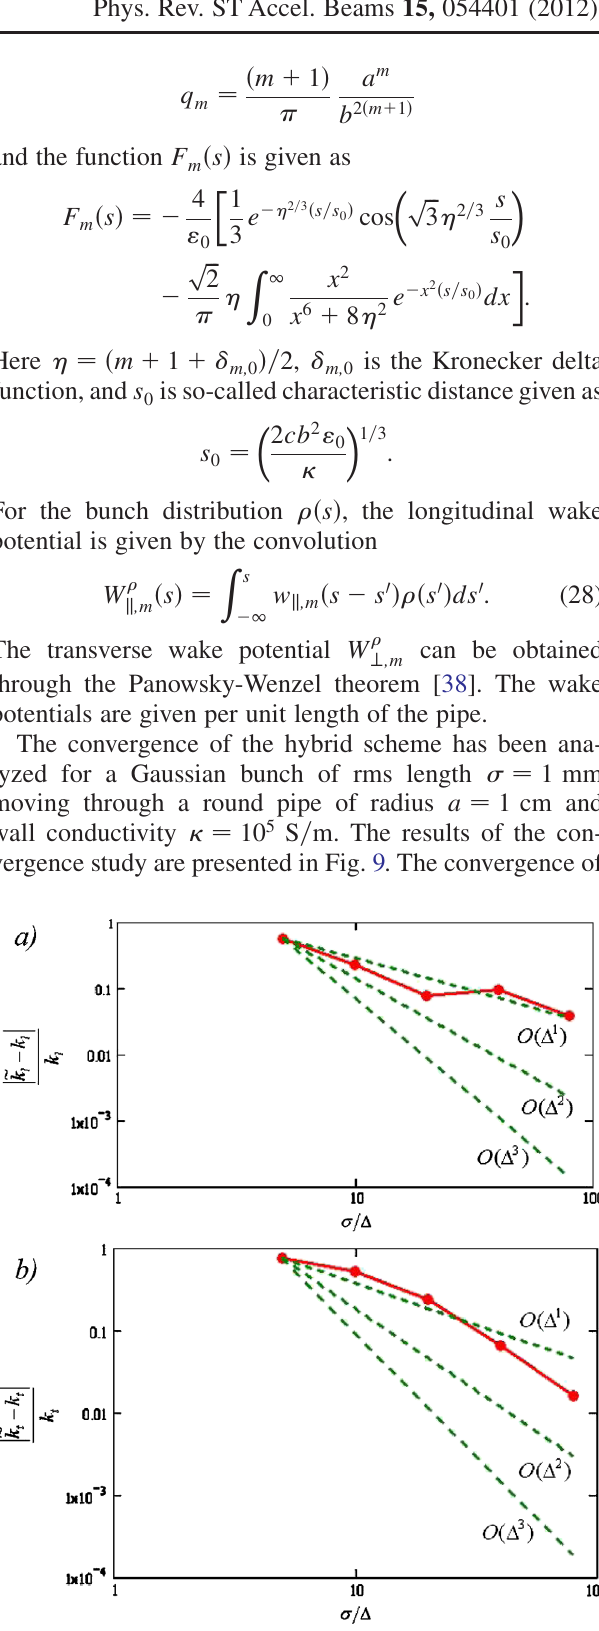
FIG. 9. Convergence (logarithmic scale) of the monopole loss and dipole kick factors (red) and predictions up to the 3rd order (green